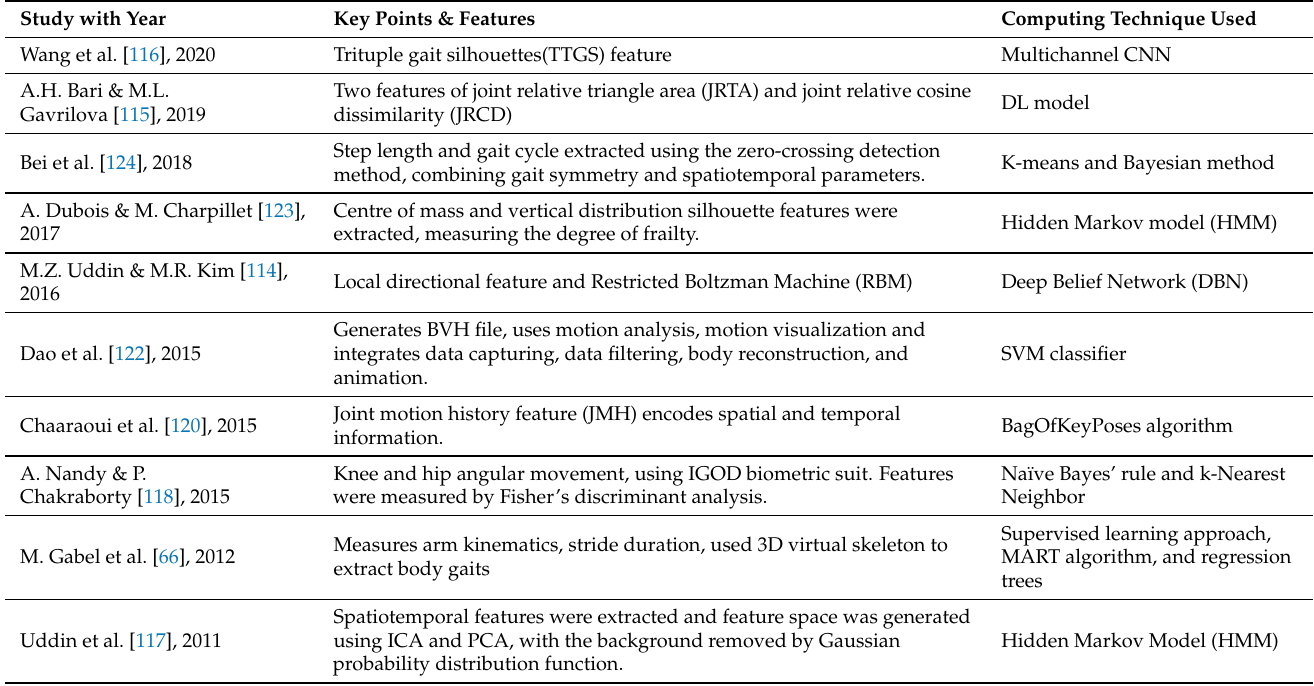
Table 4. Overview of activity analysis using depth image classification with gait